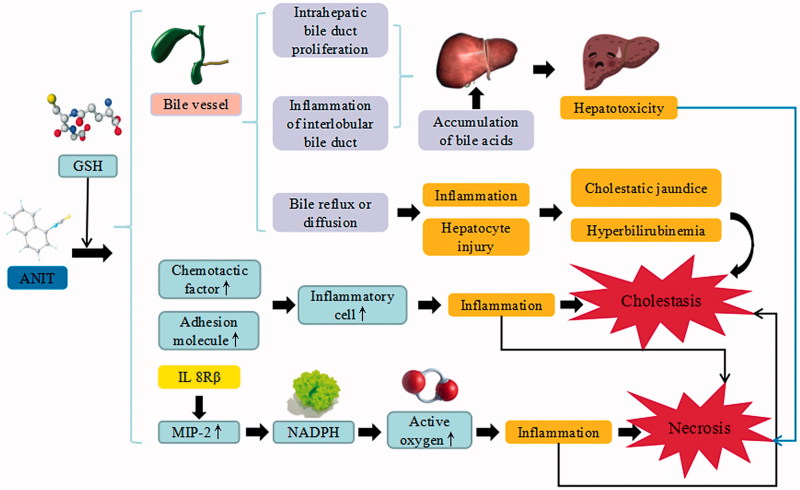
ANIT-induced liver injury. ANIT trigger the continuous development of hepatocyte injury by inducing cell stress via inflammation, hepatotoxicity, cholestatic jaundice, and hyperbilirubinemia, resulting in apoptosis, autophagy, cholestasis, and liver injury. GSH: glutathione; IL: interleukin; MIP-2: macrophage inflammatory protein-2; NADPH: nicotinamide adenine dinucleotide phosphate.